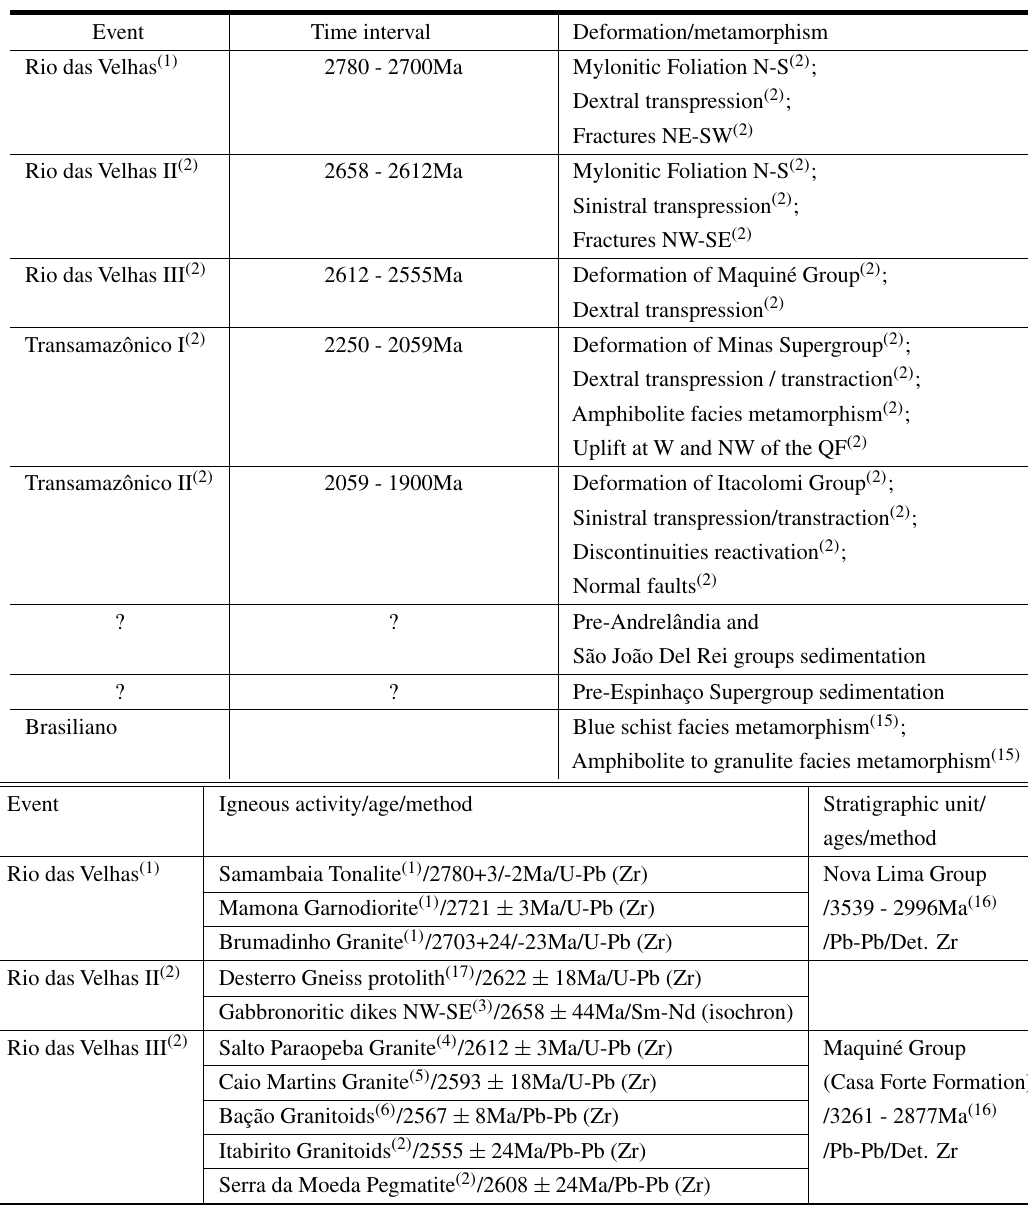
Geochronologic summary of the most significant tectonic events that took place in the Southern São Francisco Craton and its southern-southeastern margin. References: 1 – Carneiro (1992); 2 – Endo (1997); 3 – Pinese et al. (1997); 4 – Noce et al. (1998); 5 – Romano et al. (1991); 6 – Delhal and